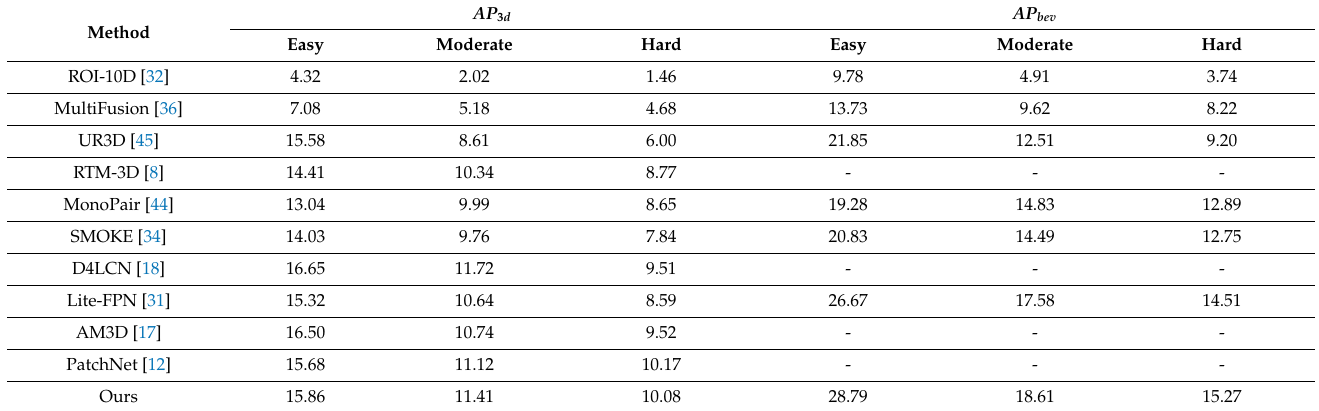
Table 2. Comparisons of and on KITTI test sets.